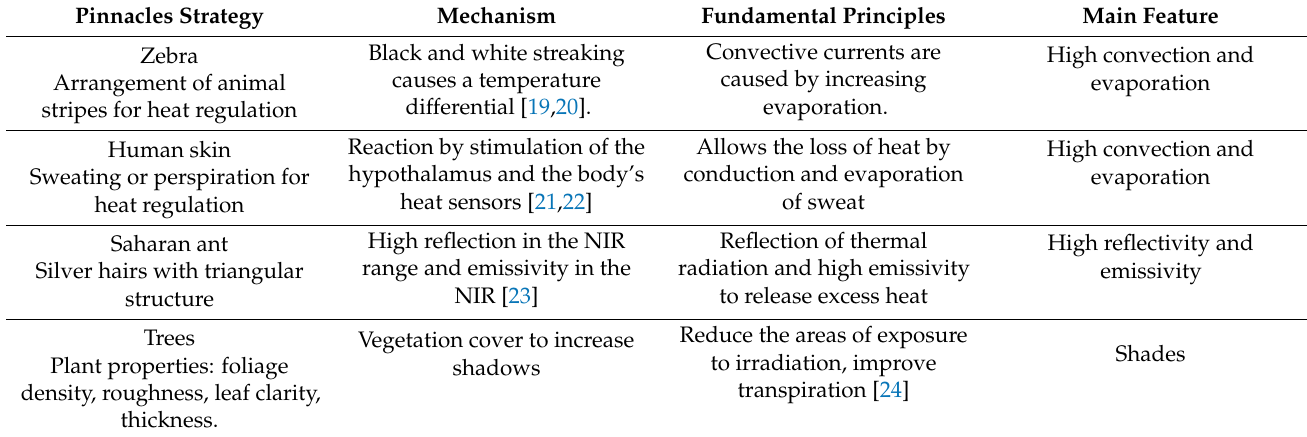
Table 2. Summary of the Pinnacles Analysis.